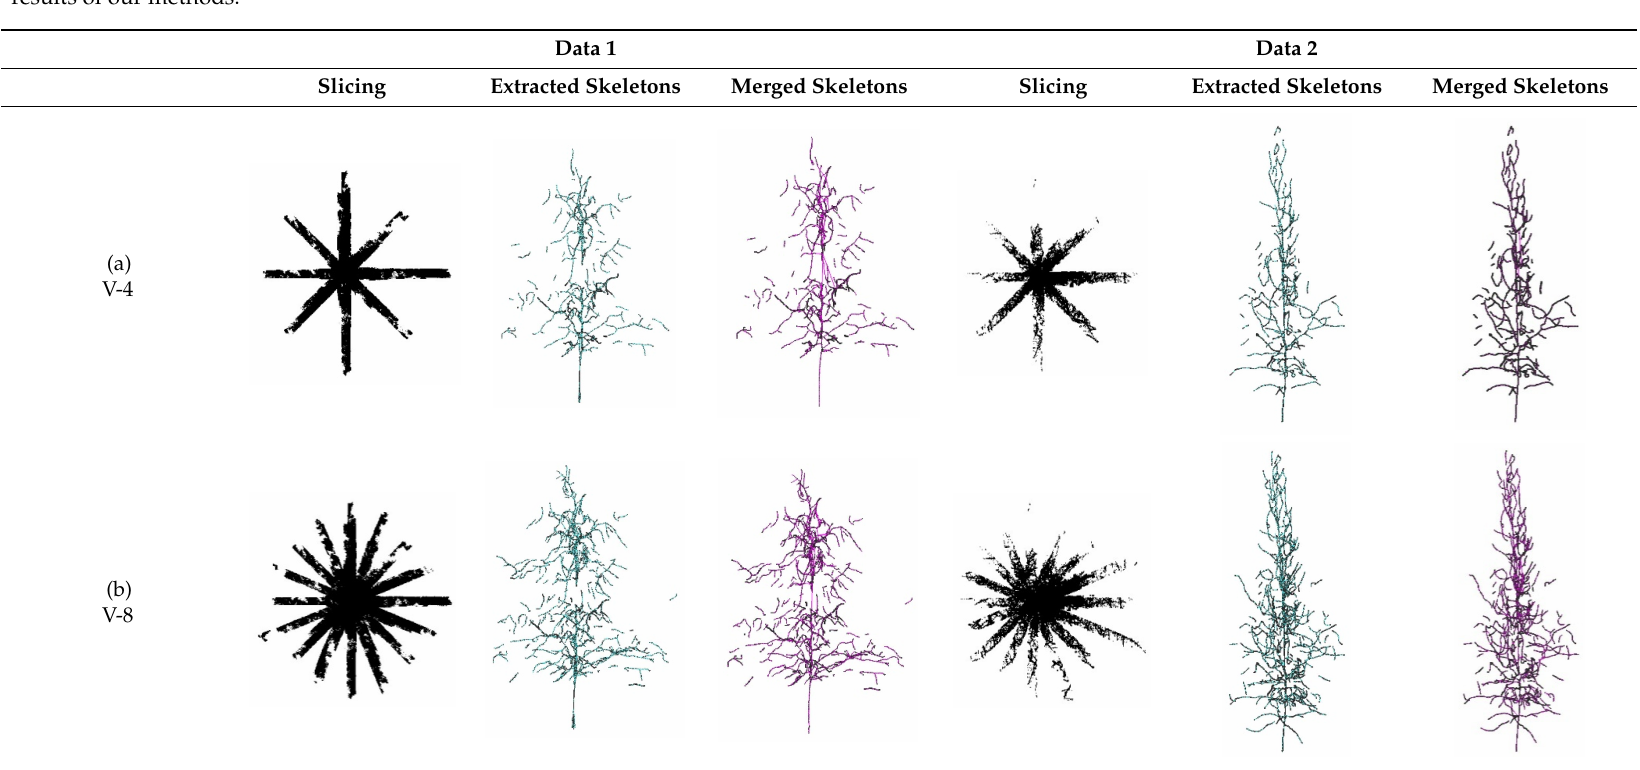
Table 1. The results of our methods on two datasets in two di ff erent seasons. The methods of slicing are presented in the first column in the form of abbreviation, such as V-4 short for the 4-equiangular division of vertical slicing and H-5 short for 5-equidistant division of horizontal slicing. The slicing columns of Data 1 and Data 2 show the side views of sliced point clouds. The vertical slicing shows the top view, and the horizontal slicing presents the front view with several virtual intervals. The columns of “Extracted Skeletons” exhibit the skeletons generated from the pieces of sliced point clouds. The columns of “Merged Skeletons” demonstrate the final results of our